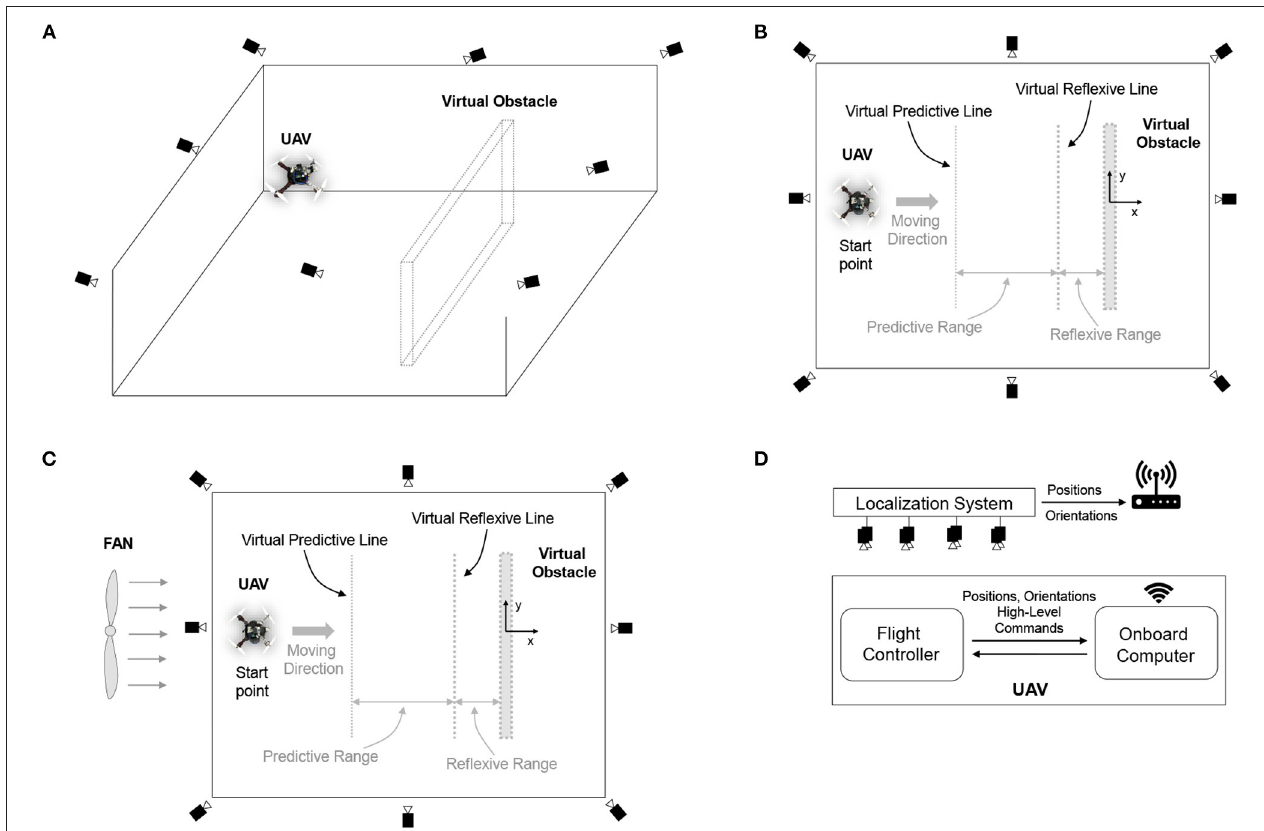
FIGURE 5 | Experimental setup for neural control with online learning of a UAV. (A) 3D view of the indoor environment for flying the UAV under the localization system, consisting of eight motion capture cameras. (B) Top view of the flying environment without wind perturbation, showing predictive and reflexive ranges with respect to the virtual obstacle. In this setup, the virtual obstacle was placed at position x = 0.0, with virtual predictive and virtual reflexive lines located at x = − 3.0 m and − 0.5 m, respectively. Basically, the predictive range was 2.5 m, and the reflexive range was 0.5 m. The UAV started flying at position x = − 4.5 m. (C) Top view of the flying environment with wind perturbation generated by a fan behind the UAV. (D) The communication system provided UAV positions (i.e., x, y, z) and orientations (i.e., roll, pitch, yaw) from the localization system to the onboard computer. The communication flow is that the localization system tracks the motion of the UAV and then sends positions and orientations to the onboard computer. The onboard computer transfers positions and orientations to the flight controller for fusing with IMU information. Subsequently, the fused information (positions and orientations) is sent back to the onboard computer to compute and generate control commands.